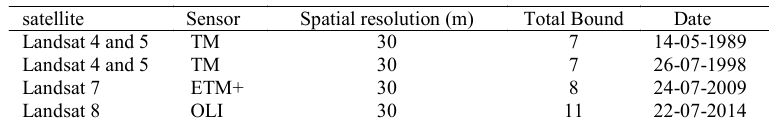
Table 1: Landsat data